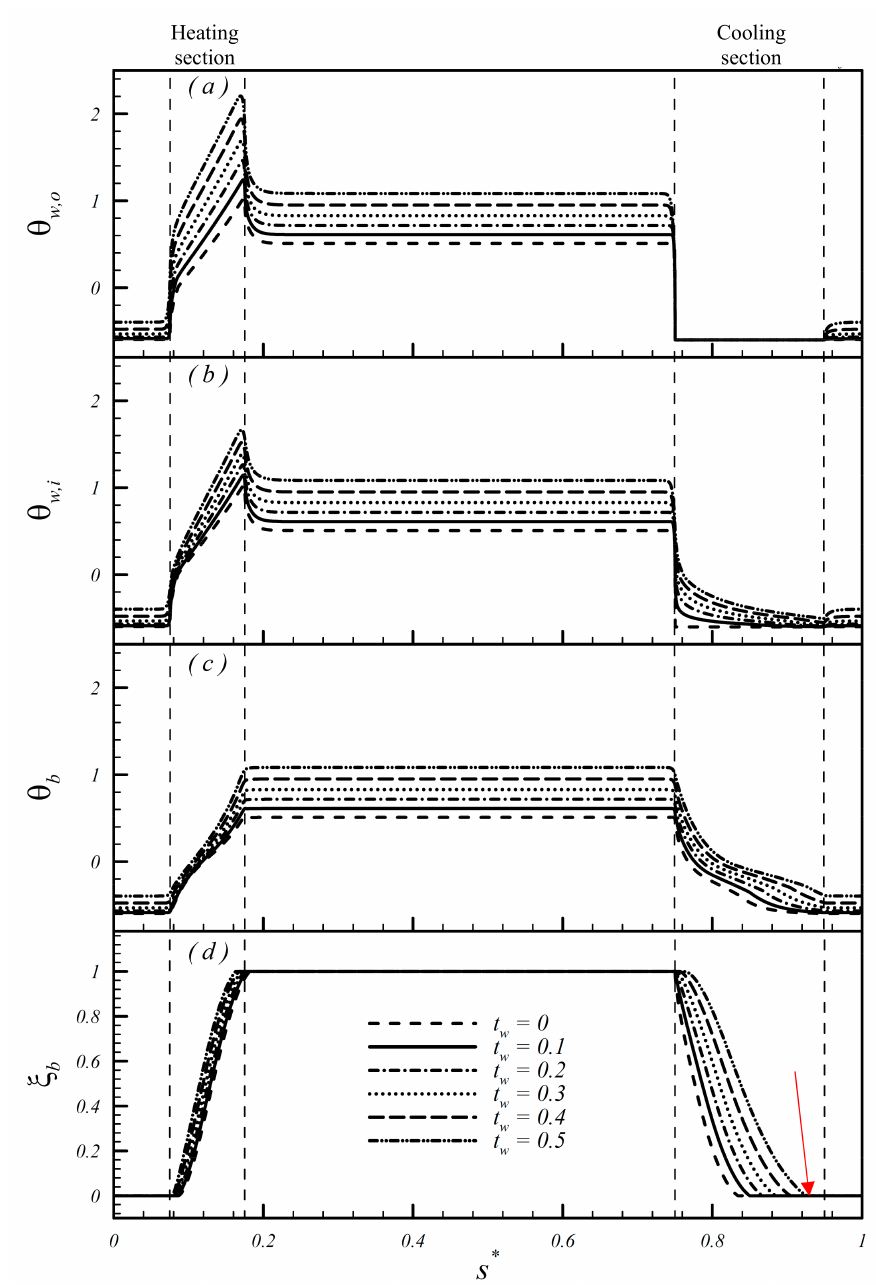
Figure 3. Axial distributions of di ff erent temperature levels ( a ) θ w , o , ( b ) θ w , i , and ( c ) θ b and ( d ) ξ b for di ff erent wall-thickness levels t w ( AR = 1, l ∗ = and k ∗ wf